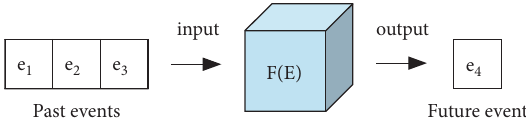
Figure 3: The event forecasting task. Source: own elaboration.